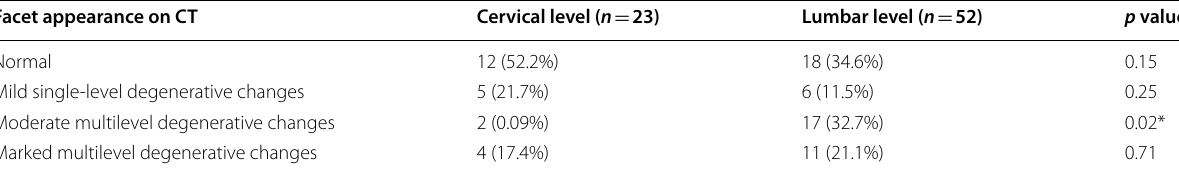
Table 3 Findings in the 75 patients with normal FDG uptake pattern within the facet joints